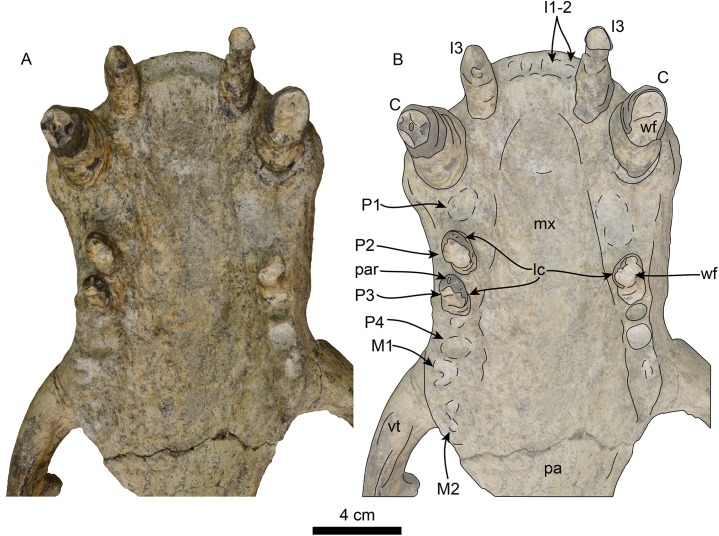
Skull of Titanotaria orangensis n. gen. et sp. (OCPC 11141).Detail of palatal region, without labels (A) and labelled (B). Abbreviations: C, upper canine; I1–3, upper incisors 1–3; lc, lingual cingulum; M1–2, upper molars 1–2; mx, maxilla; P1–4, upper premolars 1–4; pa, palatine; par, paracone; vt, ventral tuberosity; wf, wear facet.